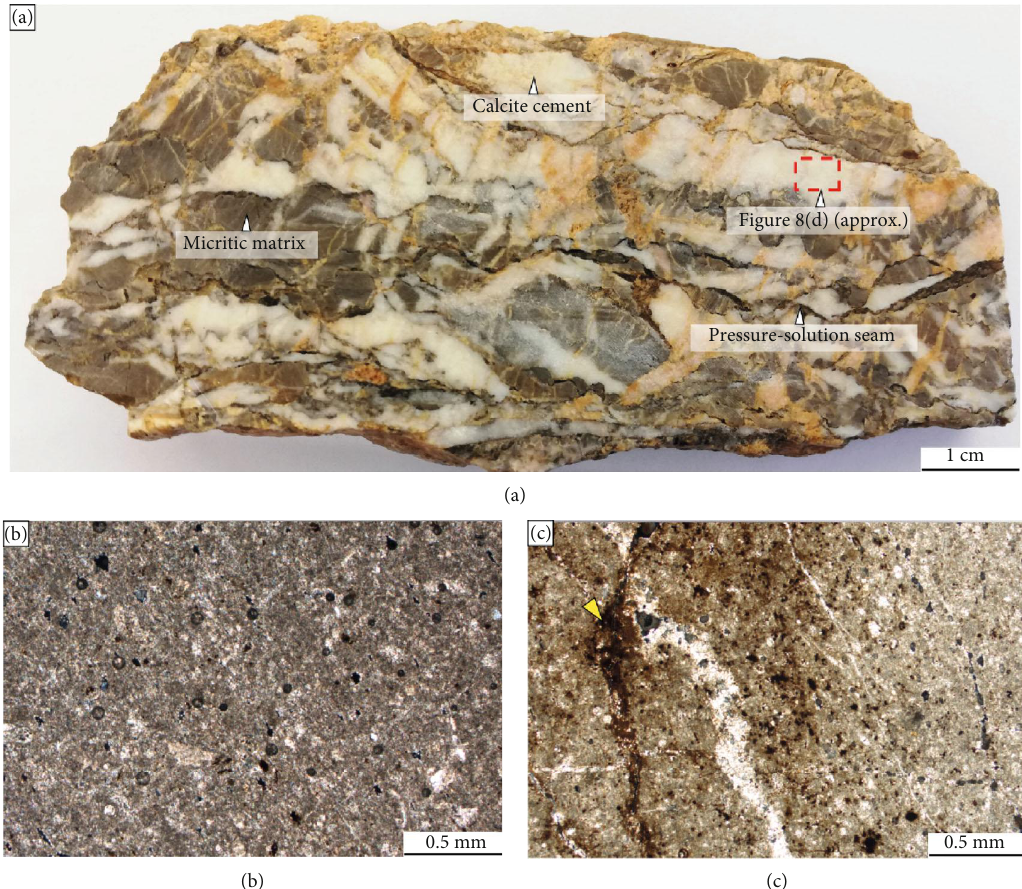
Figure 7: Fault core images. (a) Hand sample photograph of the foliated cataclasite showing S-C shear lenses (lithons) of grey host rock micritic limestone and calcite, bounded by dissolution seams or stylolites. Detail of the calcite cement can be found in Figure 8(d). (b, c) Optical microphotographs of the foliated cataclasite matrix with the presence of reddish clay minerals concentrated along pressure solution surfaces (yellow